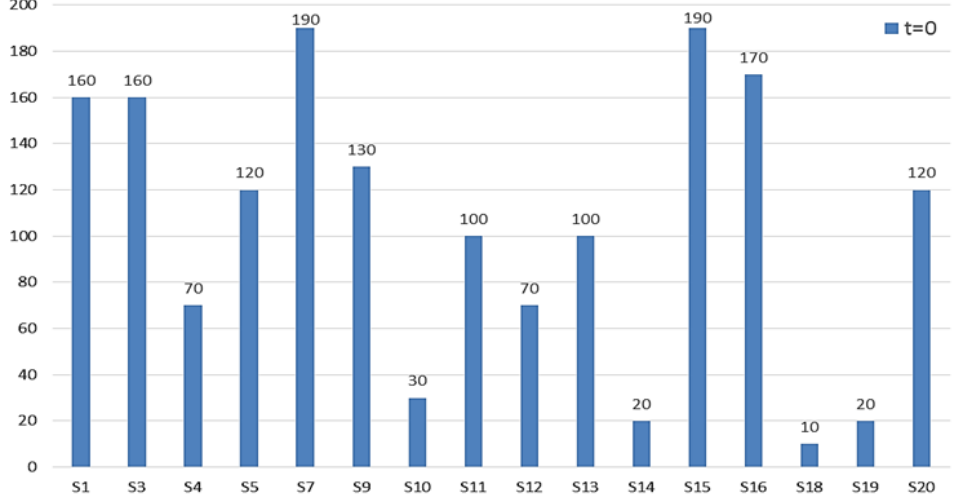
Figure 9. The demand level at IDs for instance c101_21 with 𝑚 = 1 .